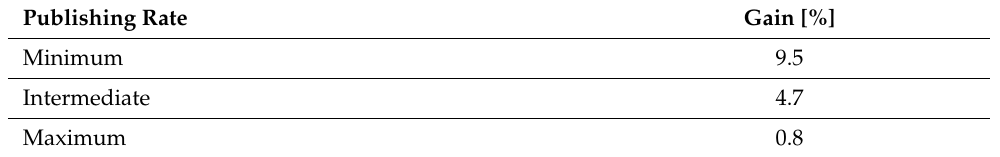
Figure 8. Comparison of WPT for different Publishing rates in Balanced Random Mesh topology. Table 2. Network lifetime gain in a Balanced Random Mesh topology for different publishing rates.